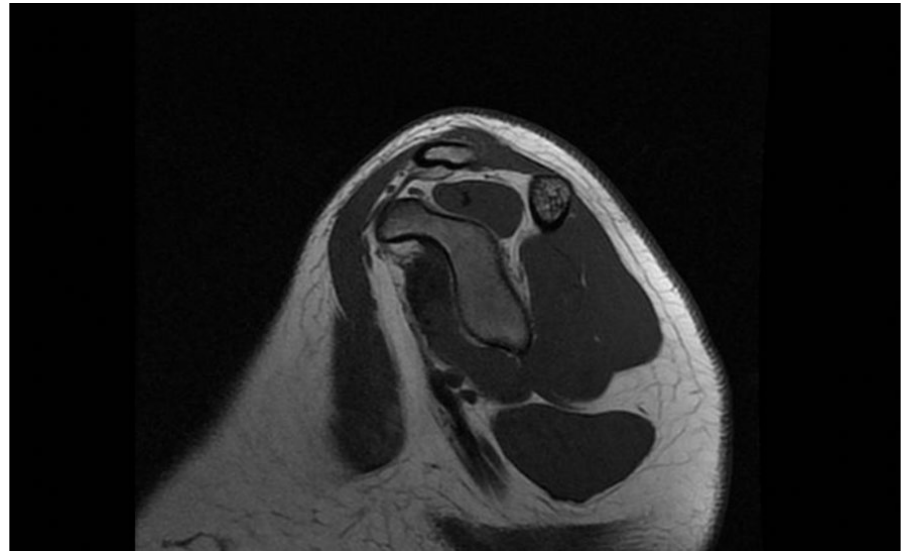
Figure 3. Trapezoidal ligament integrity in preoperative magnetic resonance imaging (MRI).